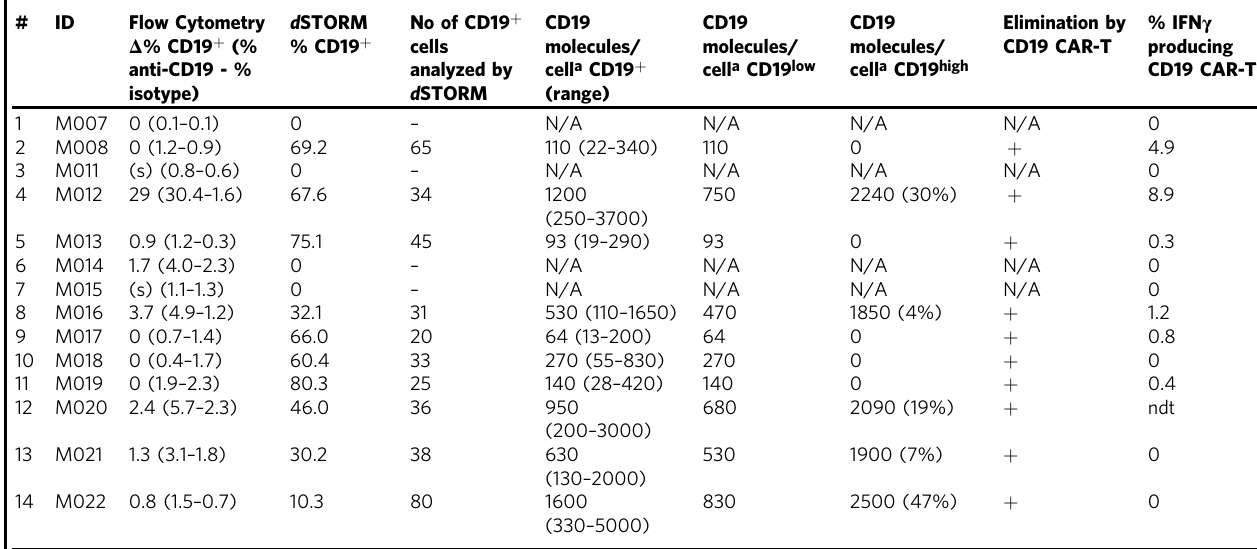
Table 1 Summary of data obtained by d STORM and fl ow